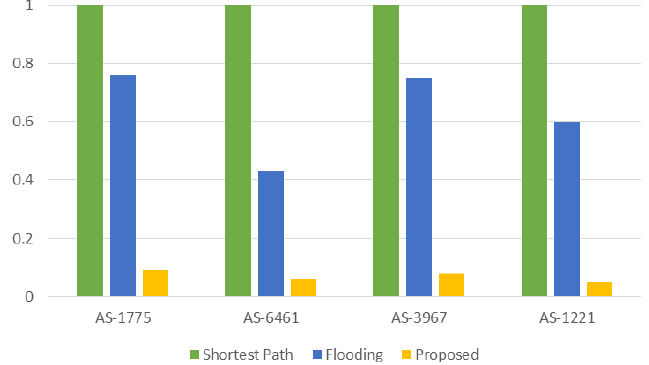
Figure 11. Comparison in memory consumption ( Mem 2 ). The proposed work consumes only 5–9% of the memory consumed by the shortest path , of which routers have the complete knowledge of all name